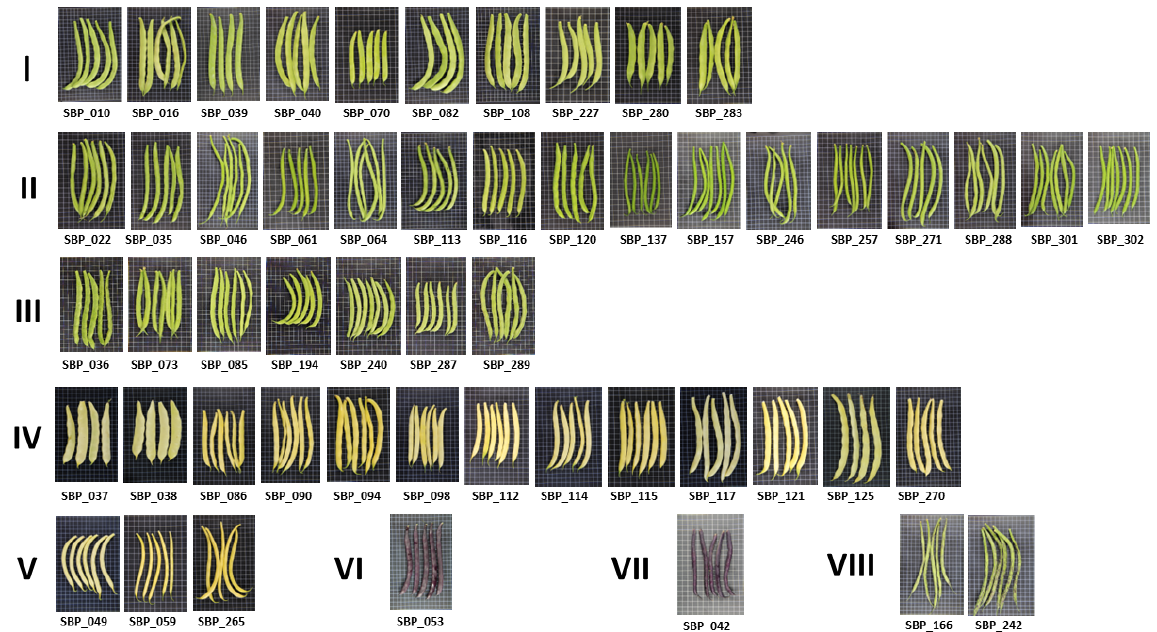
Figure 1. Classification of the lines of core-SBP into eight groups based on pod color and pod shape. I: Green/Flat; II; Green/Round; III: Green/Elliptical; IV: Yellow/Flat; V: Yellow/Round; VI: Purple/Flat; VII: Purple/Round; VIII: Mottled Green/Round. Table 2. Mean, interval of variation (Min, Max), and standard error (SE) for the traits recorded in the set of 54 snap bean lines.